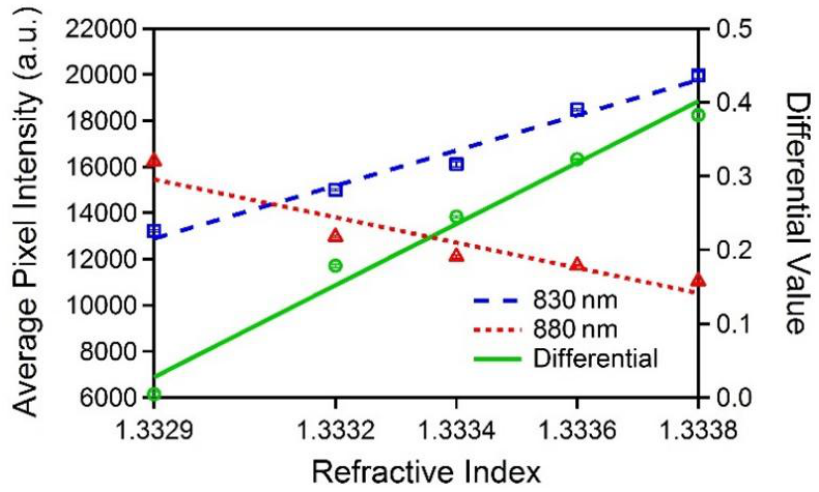
Figure 5. Measurement results showing the average pixel intensities for 830 nm (blue dashed line) and 880 nm (red dotted line) and differential value (green solid line) versus the refractive indices in the same range (1.3329–1.3338) as shown in Figure 2b.